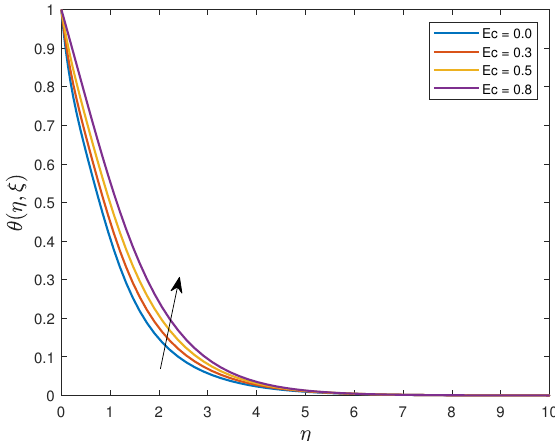
Figure 26. The influence of Ec on fluid temperature.